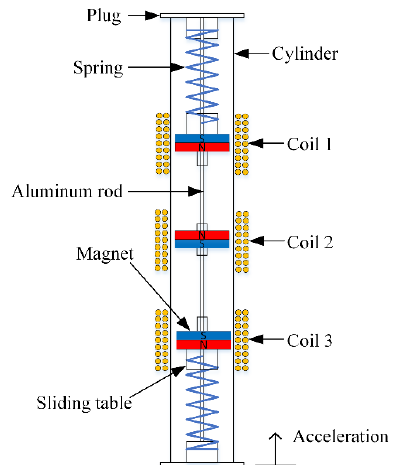
Figure 1. Schematic diagram of the magnetically coupled electromagnetic energy harvester.